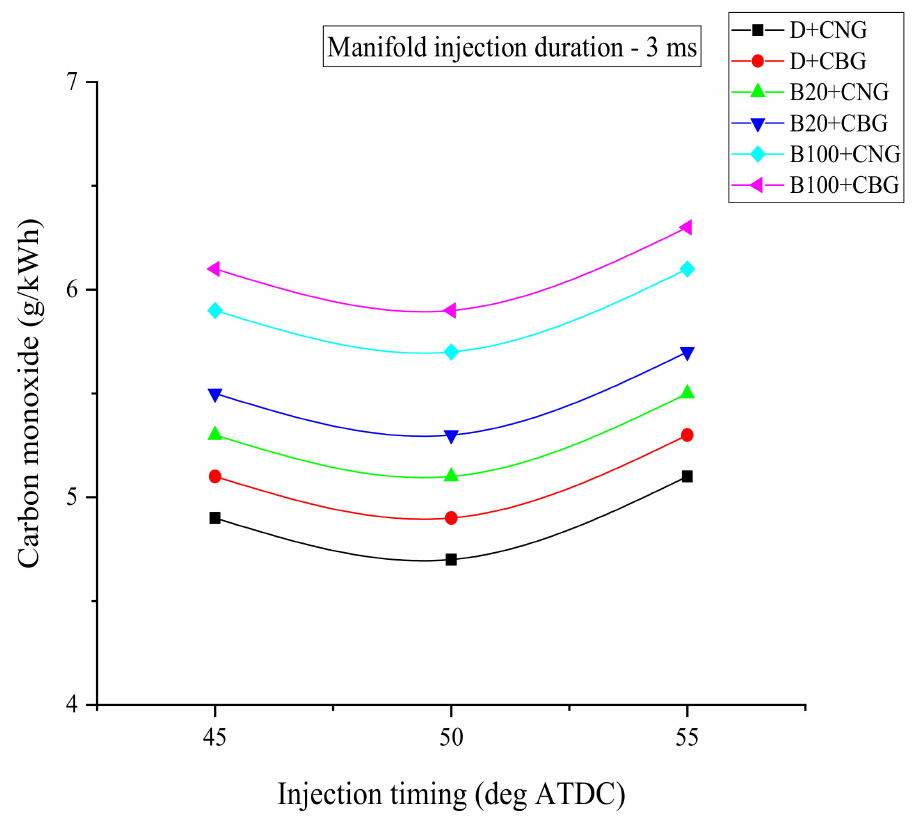
Figure 4. Variation of CO emissions with